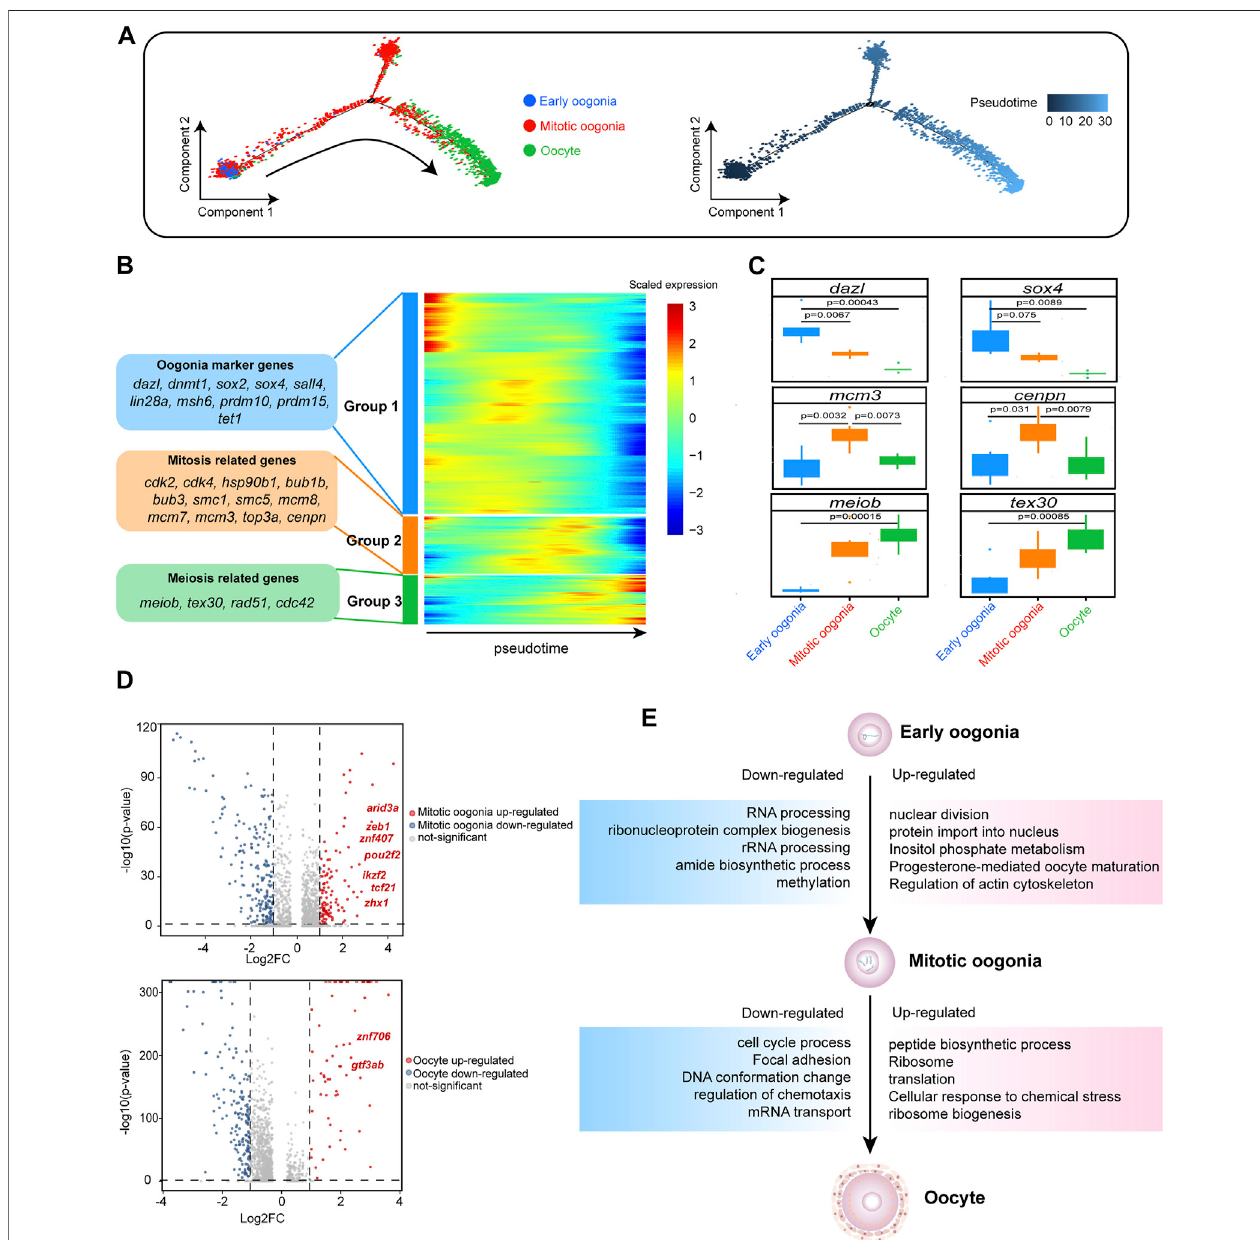
FIGURE 2 | Gene expression dynamics and transcriptional characteristics of ovarian germ cells. (A) Developmental pseudotime trajectory of germ cells. Different colours in the fi gure on the left side represent different cell types. The fi gure on the right represents the degree of differentiation of the cell types in the pseudotime trajectory (where darker colours indicate a lower degree of differentiation). (B) Gene expression heatmap over pseudotime. After clustering analysis, genes were divided into three groups (Groups 1 – 3) (representative genes are shown on the left). Colours from blue to red indicate low to high gene expression levels, respectively. (C) Boxplot showing the mean expression levels of oogenesis-associated genes in each germ cell subtype. Two-tailed t test p -values are indicated. (D) Volcano plot showingtheDEGsofgermcells,settingafoldchange > 2asthethreshold (dotted line).Intheupper fi gure,upregulatedgenesinmitoticoogoniarelative toearlyoogonia are indicatedinred, anddownregulatedgenesareindicatedinblue. Inthe lower fi gure,upregulated genesinoocytes relative tomitoticoogoniaareindicatedinred,and downregulated genes are indicated in blue. Upregulated transcription factors (TFs) are labelled. (E) DEGs and associated enriched terms (identi fi ed using Metascape) characteristic of germ cell developmental transitions, based on Figure 2D . Upregulated terms are annotated in pink boxes, and downregulated terms are annotated in blue boxes.